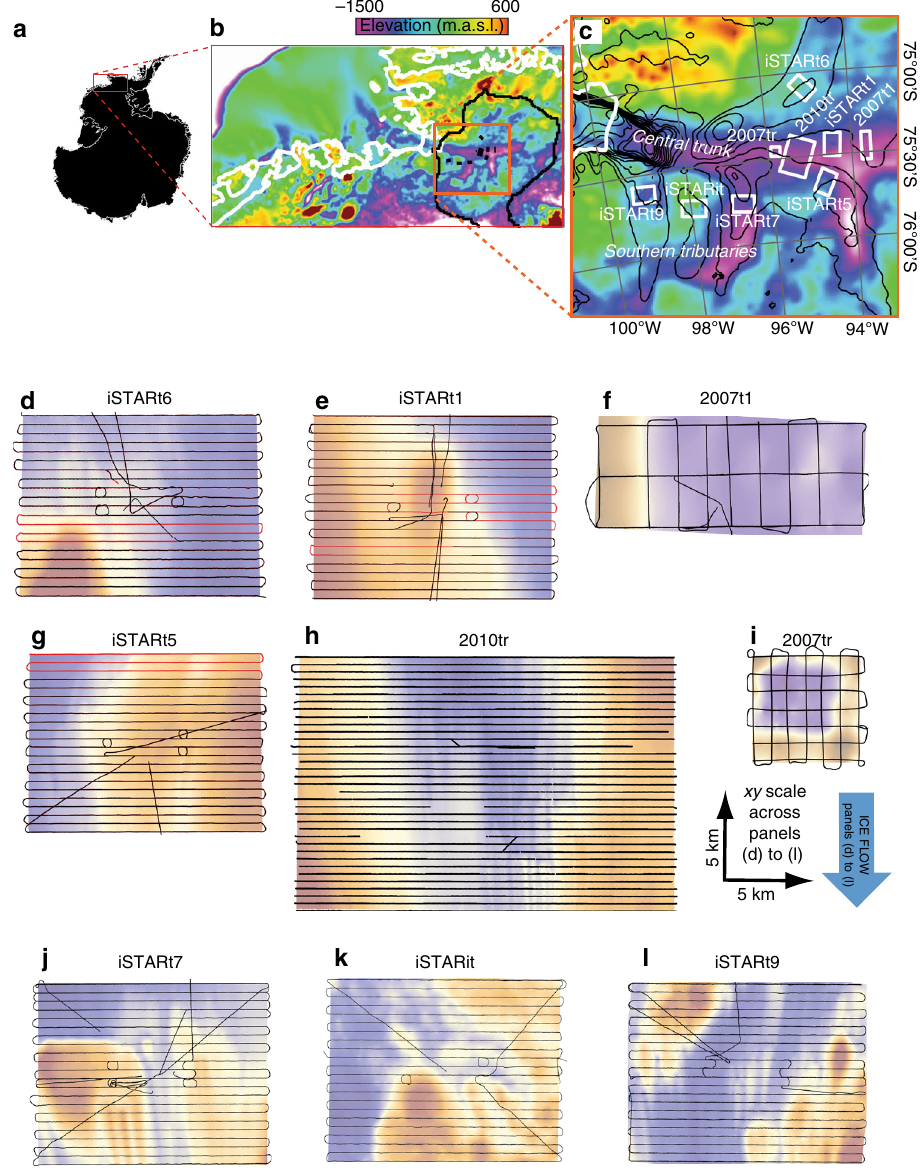
Fig. 4 Radar coverage. a Location and context. In b , the colourmap shows regional bed topography from Bedmap2 23 , the black line is the ice divide, the white line is the grounding line 51 and high-resolution survey patches are shown as black rectangles. Locations of offshore bathymetry shown in Fig. 2c, f are marked. c uses the same schema but demarcating survey patches with white rectangles, labelled by season of data acquisition (2007/08, 2010/11 and ‘ iSTAR ’ = 2013/14) and an end label denoting the location (where ‘ tr ’ = trunk; ‘ it ’ = intertributary and ‘ t1, t5 …’ denote tributaries numbered after ref. 52 . Also shown are surface ice velocities 53 contoured at 100-m intervals. d – l Plan views of each radar-survey patch across PIG. The colourmap shows bed elevation (scales in Fig. 1). Black lines depict radar tracks with dual-frequency GPS navigation. Red lines in d , e , g depict traverses where the dual-frequency GPS failed and navigation was recovered as described in the Methods